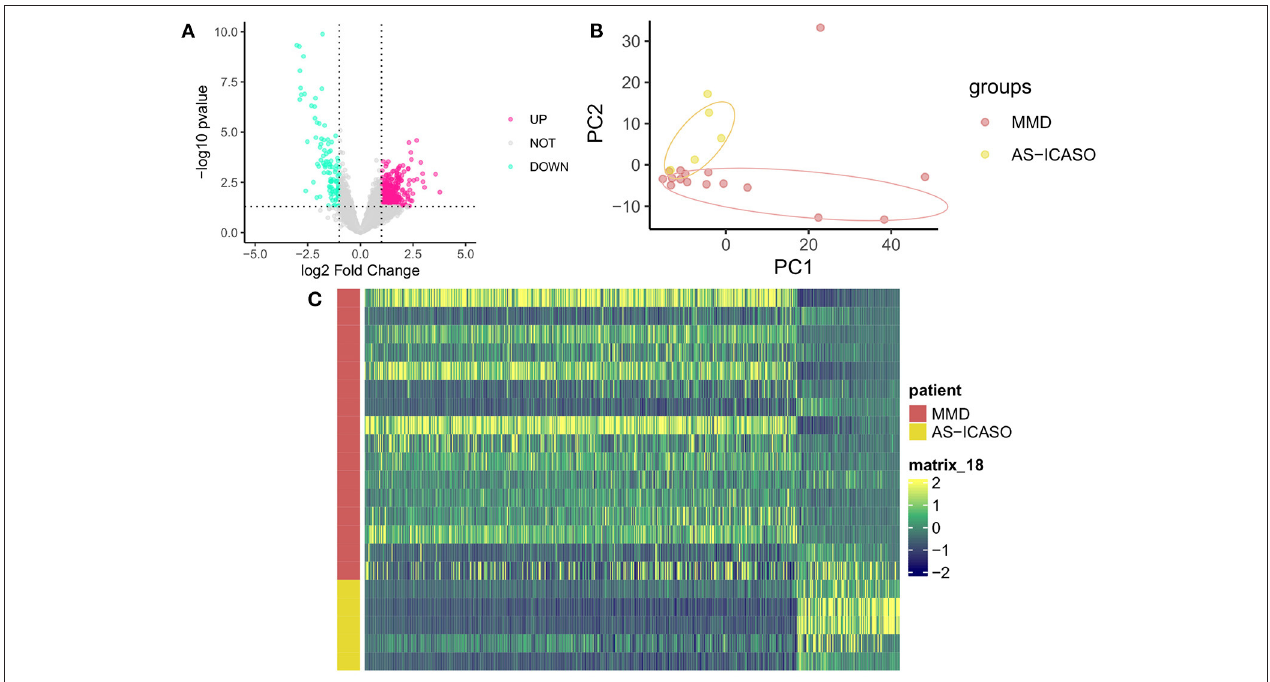
FIGURE 2 | Dysregulated genes in MCA specimens from MMD and AS-ICASO controls. (A) A volcano plot to visualize the DEGs between MMD and AS-ICASO controls. Magenta dots represent significantly ( p < 0.05 and fold change > 2) upregulated genes ( n = 449), and indigo dots represent significantly downregulated genes ( n = 107). Gary dots represent the genes that are not differentially expressed. (B) A principal component analysis (PCA) biplot for PC1 and PC2, performed using all of the normalized values obtained from the sequencing data, shows two separate clusters for MMD and AS-ICASO controls. Dark red dots represent patients with MMD, yellow dots represent participants with AS-ICASO. (C) Heatmap shows a distinct expression pattern of DEGs between MMD and AS-ICASO controls. The color key at the right indicates a relative gene expression. Yellow and green colors represent higher and lower gene expression levels, respectively.